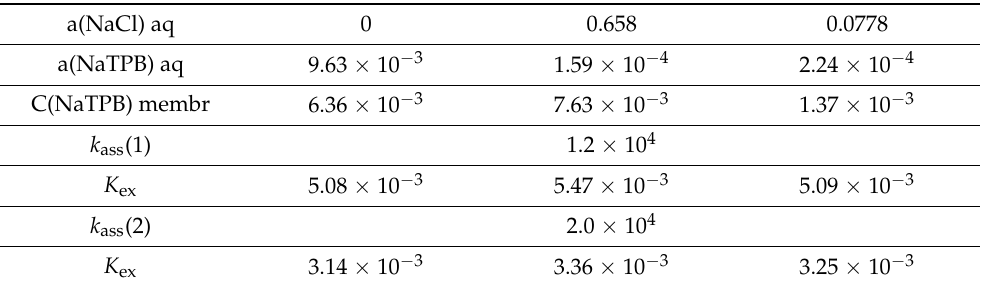
Table A2. The equilibrium NaTPB concentrations in the membrane phase, activities in water solution, and calculated values of coextraction constants for the values of association constants determined in two